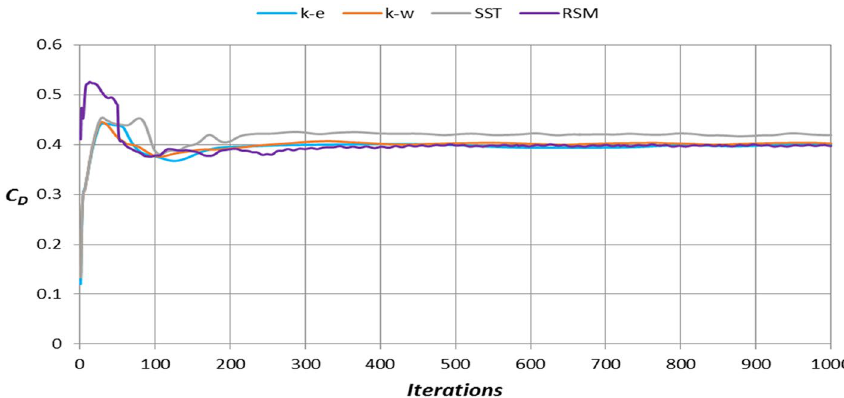
Figure 11. The drag coefficient for the baseline model uses four types of turbulence models.